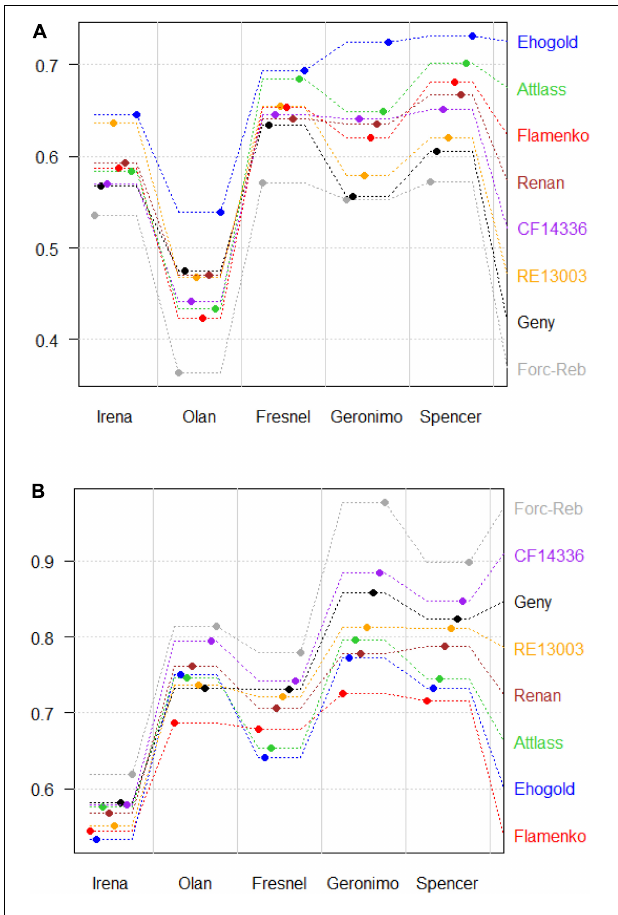
FIGURE 4 | Mean partial (A) wheat (LERw) and (B) legume (LERl) land equivalent ratios across environments for 8 wheat genotypes intercropped with 5 legume testers. The wheat genotypes are ranked from left to right for each tester according to their average LER across all the 5